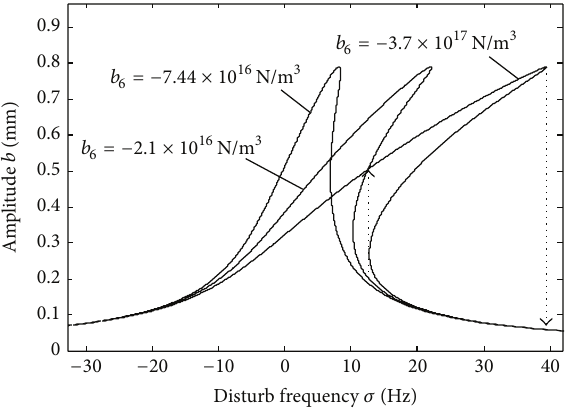
Figure 6: Main resonance amplitude frequency curve of different nonlinear stiffness 𝑏 6 .